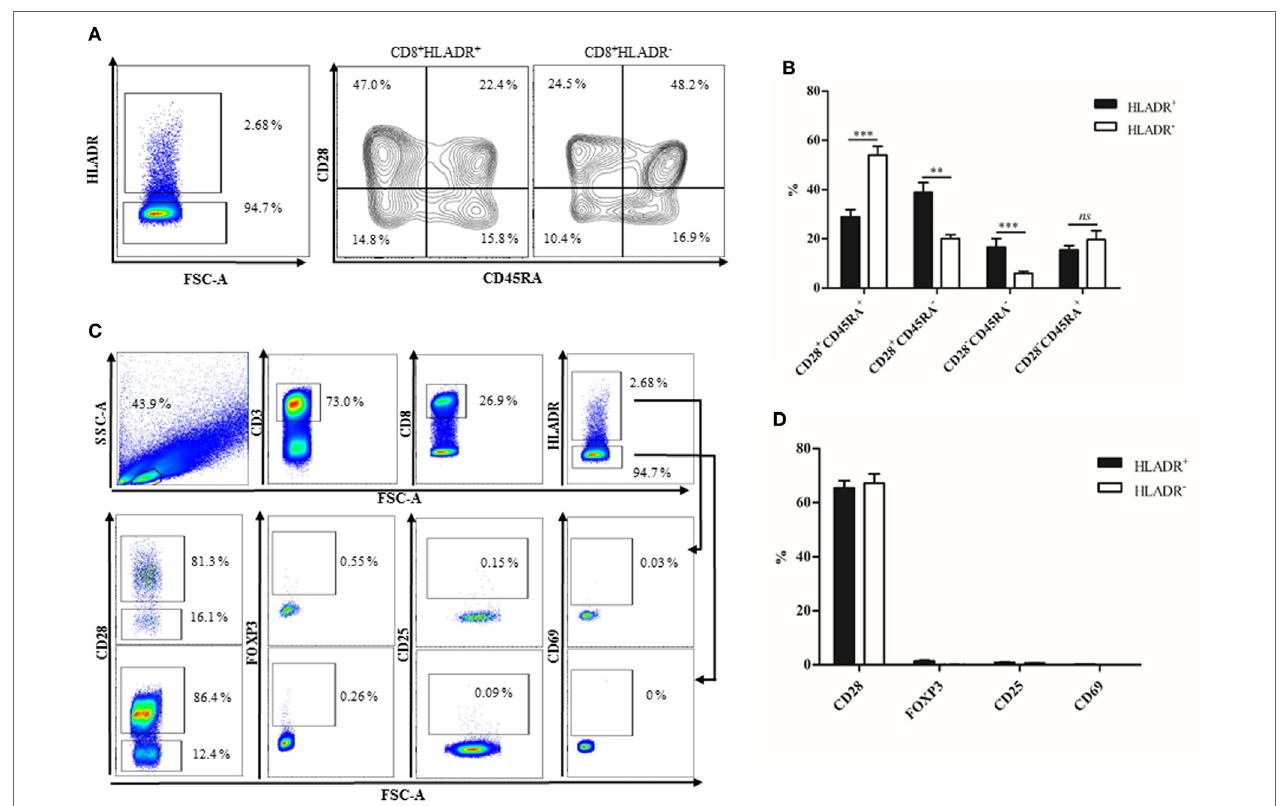
FigUre 2 | Phenotypical characterization of CD8 + human leukocyte antigen–antigen D related (HLADR) + and CD8 + HLADR − T cells. (a) Representative FACS plots demonstrating the expression of CD45RA and CD28 in HLADR + and HLADR − cells from a young donor. (b) Percentages of HLADR + and HLADR − cells (CD28 + CD45RA + , CD28 + CD45RA − , CD28 − CD45RA − , and CD28 − CD45RA + cells), young donors n = 24 ( < 30 years), mean ± SEM, ** p < 0.001, *** p < 0.0001, ns, not significant. (c) Representative FACS plots of activation markers and other molecules in CD8 + HLADR + and CD8 + HLADR − cells. The upper panel represents the gating strategy. (D) Percentages of CD28, FOXP3, CD25, and CD69 in CD8 + HLADR + vs CD8 + HLADR − cells; mean ± SEM, young donors n = 22 ( < 30